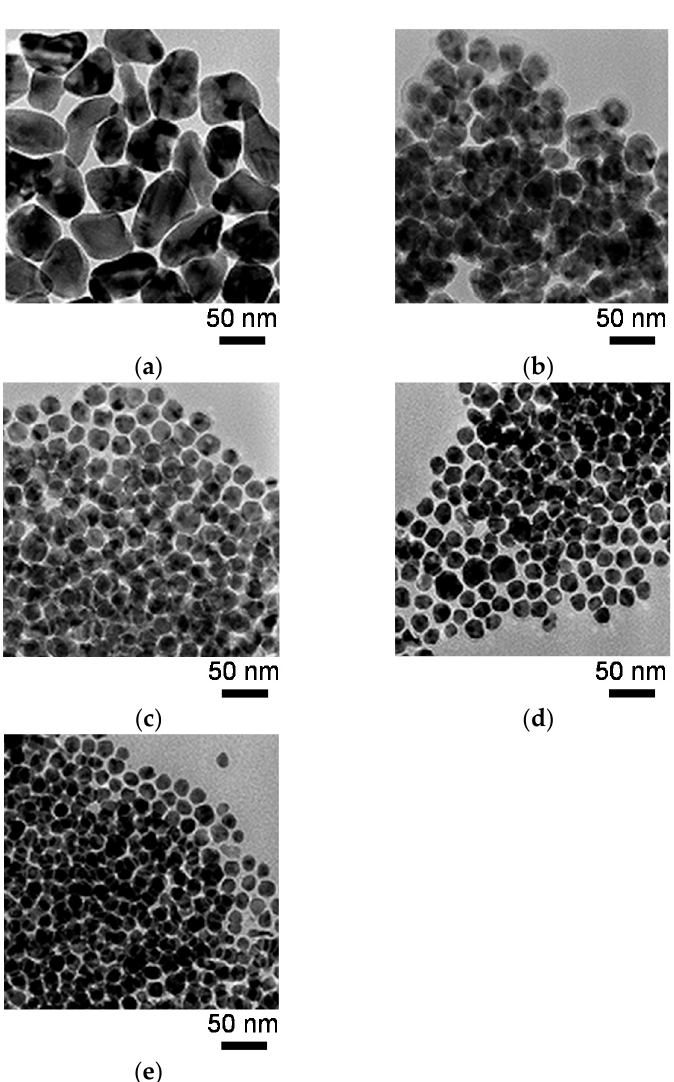
Figure 4. Transmission electron microscopy (TEM) images of the Ni nanoparticles at the TOP/Ni ratios of ( a ) 0, ( b ) 0.1, ( c ) 0.3, ( d ) 0.5, and ( e ) 0.8.